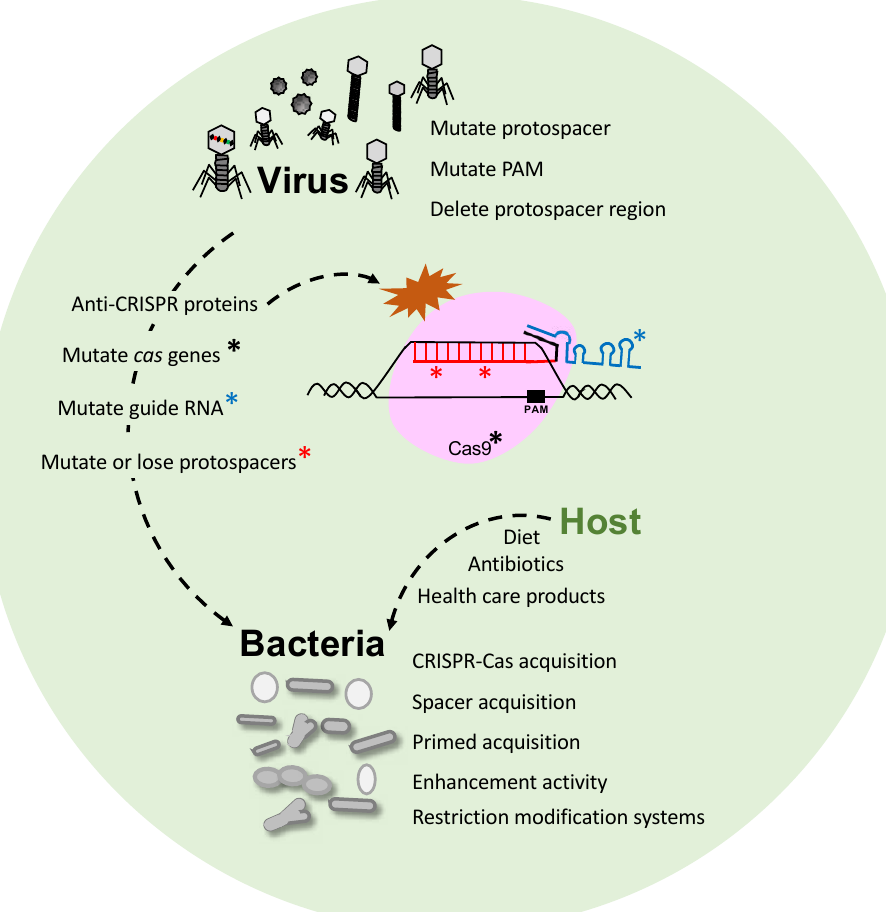
Figure 3. Phage-bacteria dynamics. Interaction and evolution of phage and bacteria developing next generation defense mechanisms, and escape strategies. Bacteria have developed CRISPR-Cas immune systems, among others, that defend against predatory attack from phages whereas the phages also evolve (i) mutating their genome to escape CRISPR targeting; (ii) introducing mutations into CRISPR systems or (iii) developing anti-CRISPR proteins to inactivate the Cas